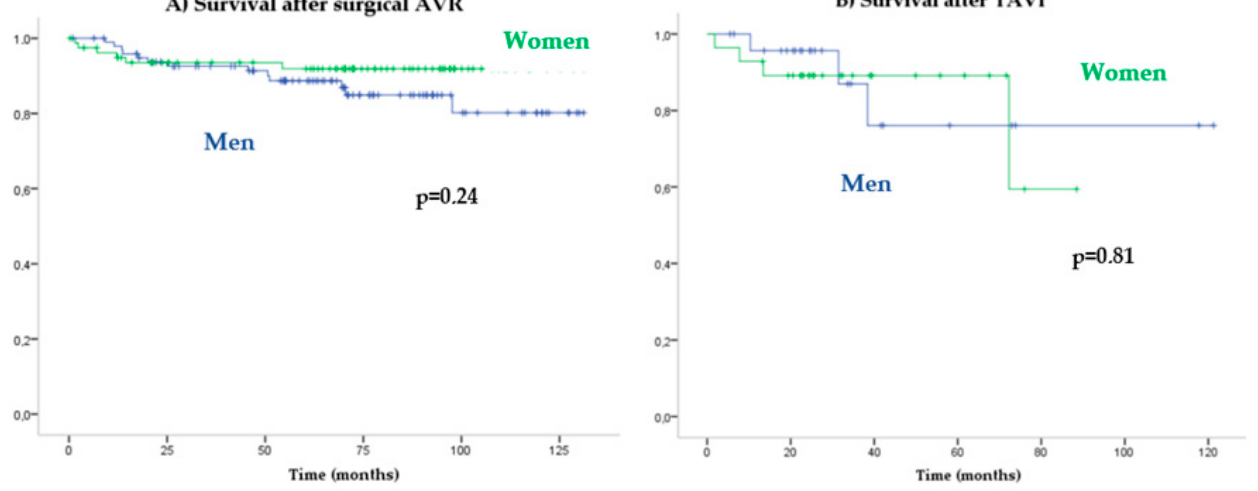
Figure 4. Kaplan–Meier cardiovascular survival according to type of AVR.